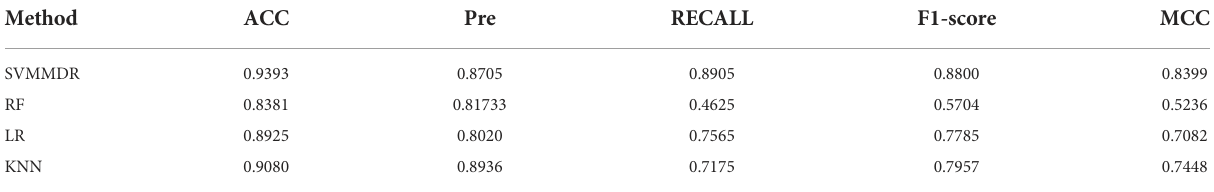
TABLE 2 Performance comparison of existing machine learning methods.